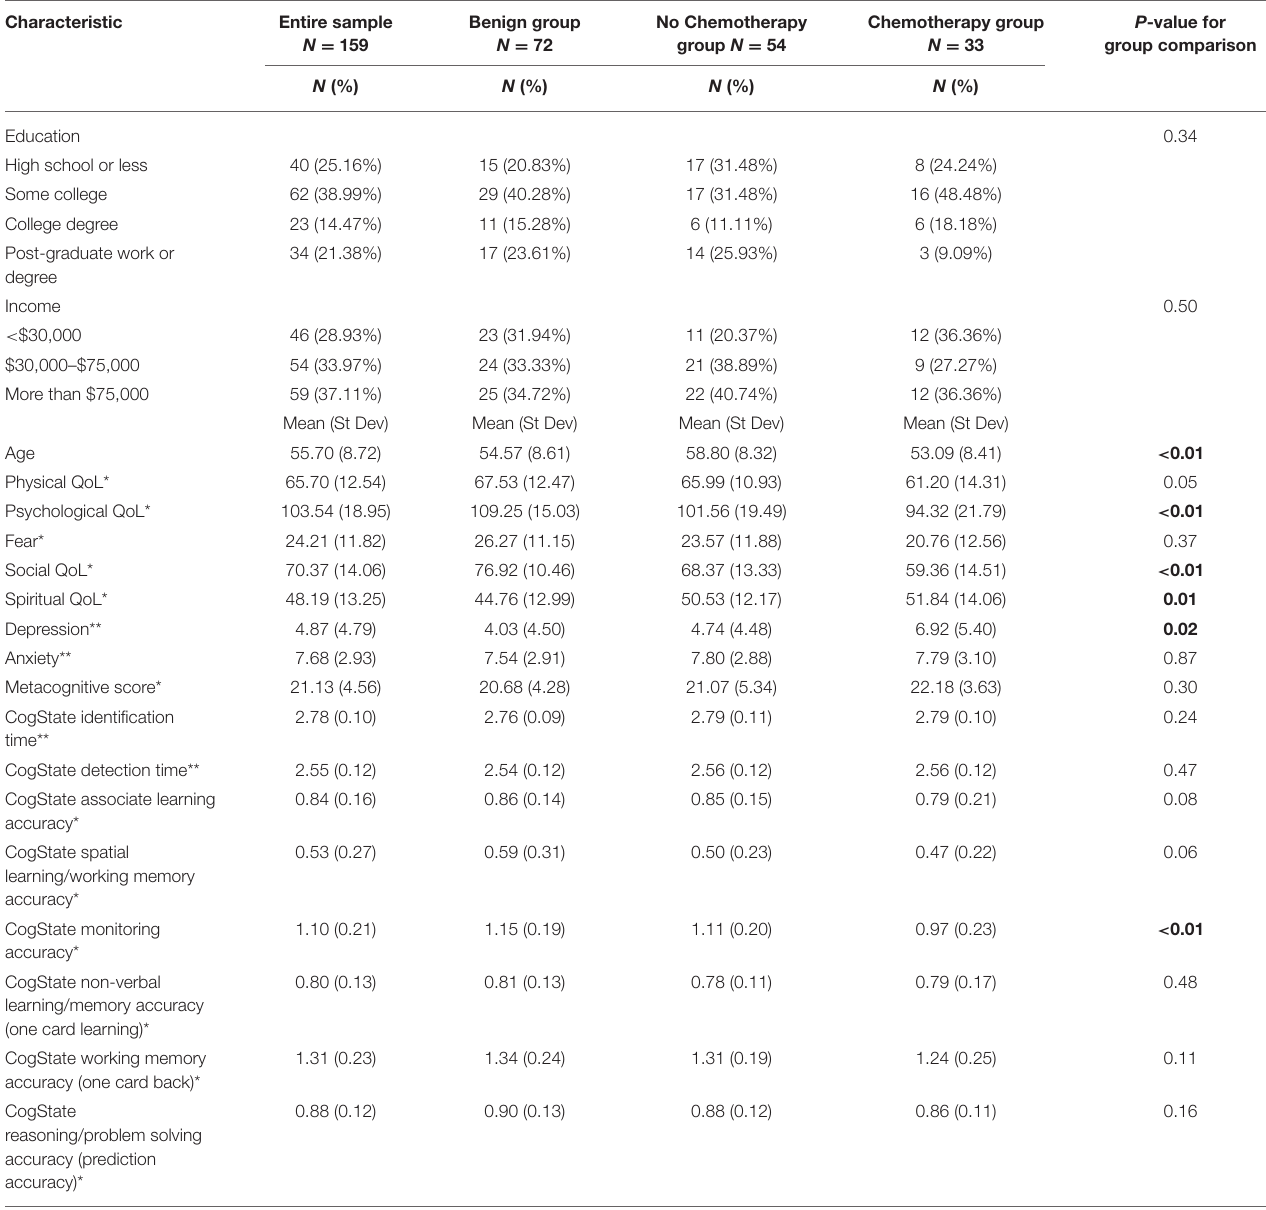
TABLE 1 | Demographic characteristics and outcomes at